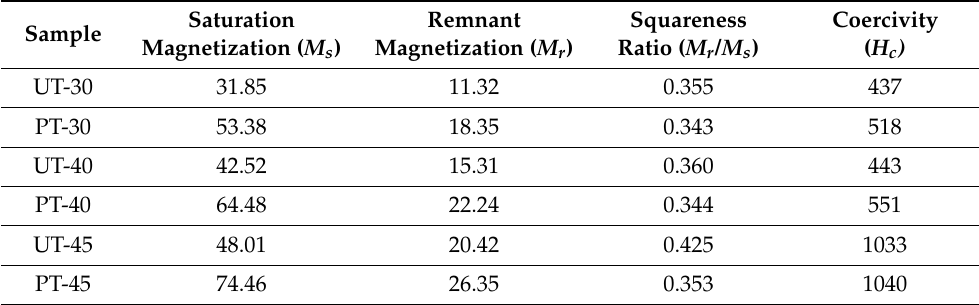
Table 2. Measurements of magnetic properties of NiCuZn ferrite samples.